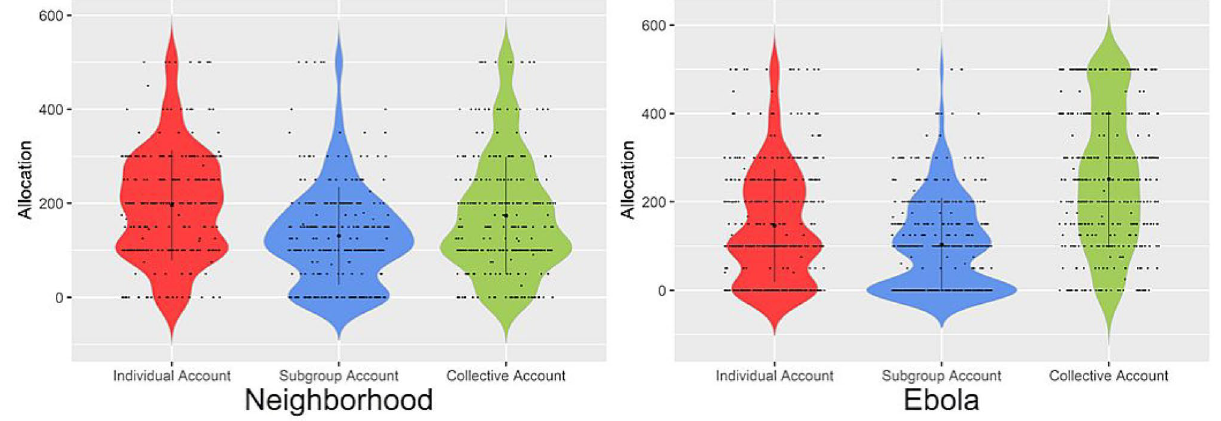
Figure 2. Allocations to individual, subgroup, and collective accounts in the Neighborhood and Ebola scenarios. Dots represent individual data points across all four studies.